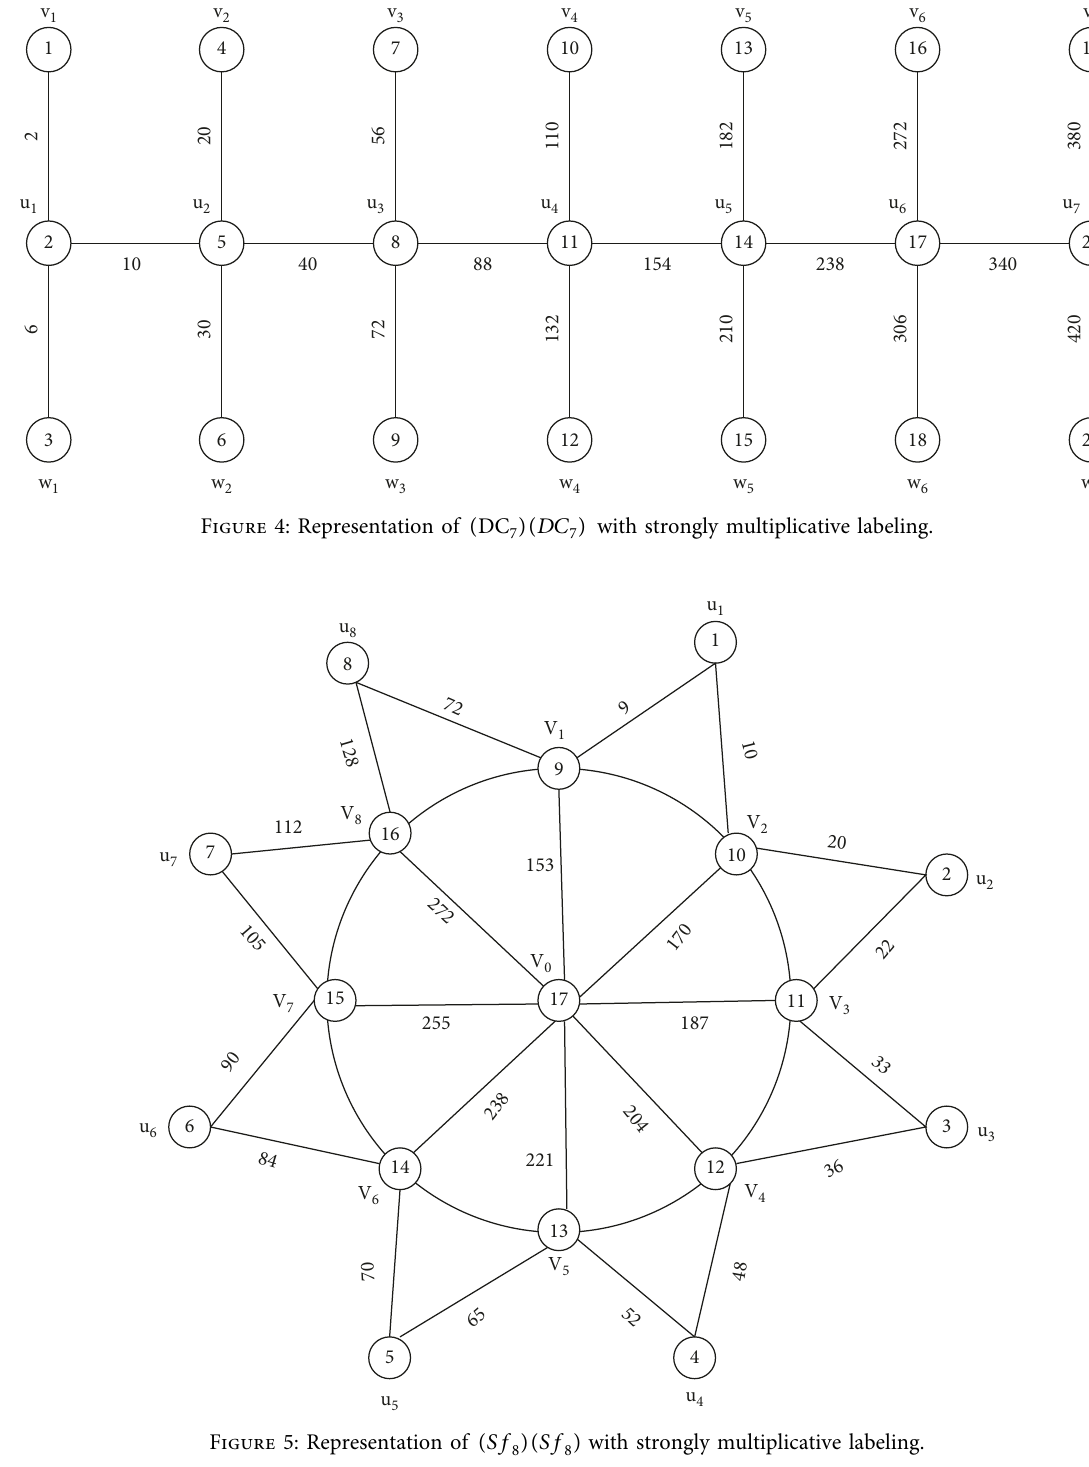
Figure 5: Representation of ( Sf )( Sf ) with strongly multiplicative 8 8 According to this mapping, the products of label of two end vertices are the induced edge labels which are also distinct, i.e., no two edges have same labels. Hence, the double comb graph ( DC n ) is a strongly multiplicative graph.